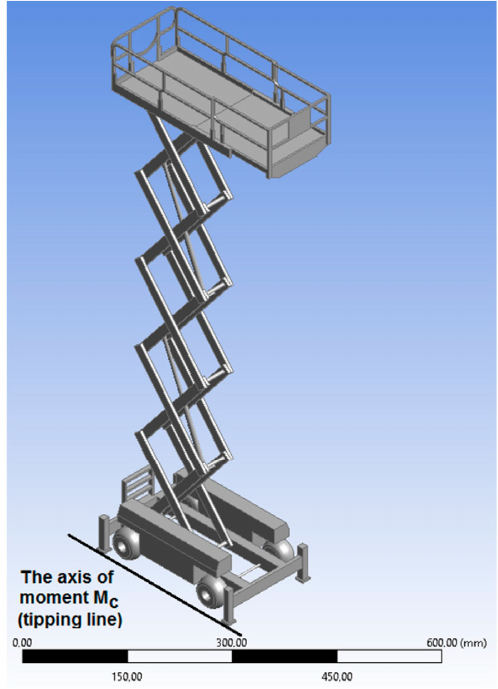
Figure 8. The CAD model of the studied scissor lift created with the use ANSYS Design Modeler R22.